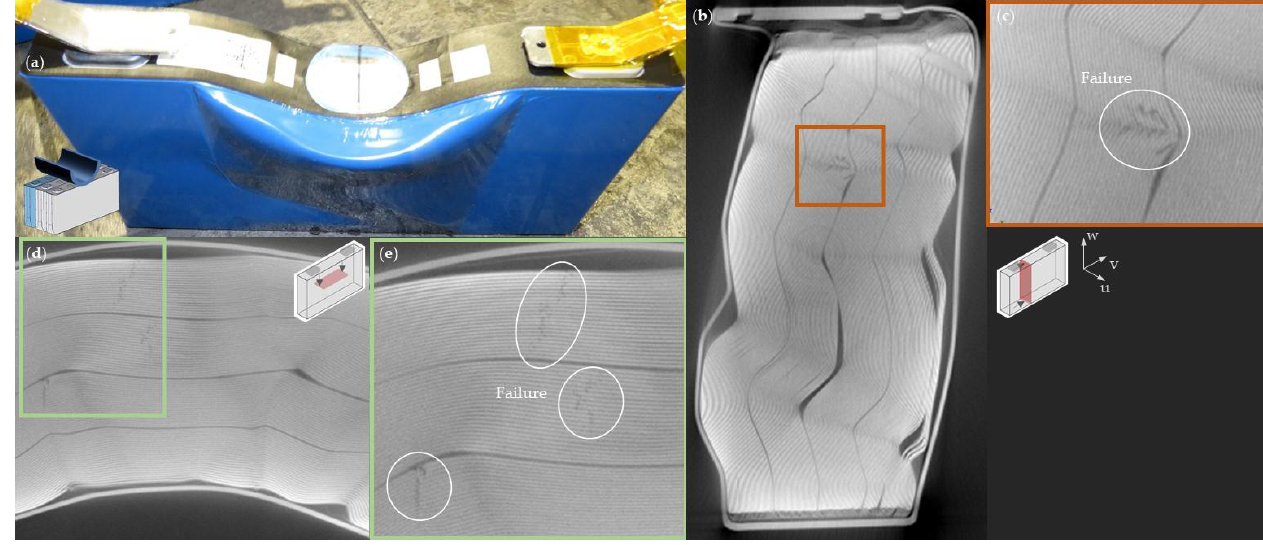
Figure 18. W-direction with cylindrical impactor: ( a ) deformed middle cell; ( b – e ) CT-Scans. The failure of the electrodes layers in the middle cell has augmented the importance of the CT-Scans investigation of the left cell of the battery stack involved in the w-direc- tional cylindrical compression test. Therefore, similar locations were selected as for the middle cell and a similar kind of revelation can be observed in Figure 19. The layers of electrodes in the left cell were also damaged at several locations. In addition, delamination of jellyroll layers and great deformation of the cell casing is quite evident.